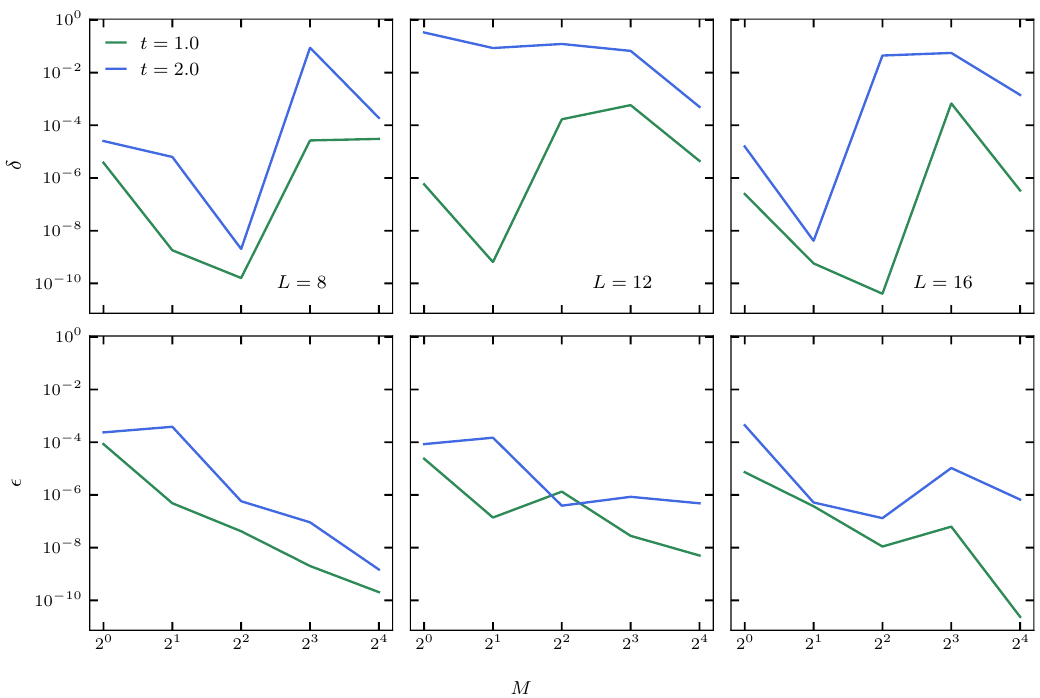
Figure 17: The average gate-wise infidelity δ of every gate with its mirrored counter- part (top panels), flipped across the middle bond, for all gates in compressed circuits which were optimized to approximate the lattice inversion symmetric Heisenberg chain time-evolution operator. For comparison, we also show the infidelity ε of the circuit as a whole with its mirrored counterpart (bottom panels). These quantities probe to which extent the inversion symmetry of the targeted unitary emerges in the compressed circuit. The infidelities are shown as a function of the circuit depth M , for times t = 1 and t = 2. The left panels are for system size L = 8, the middle panels are for L = 12, and the right panels are for L =